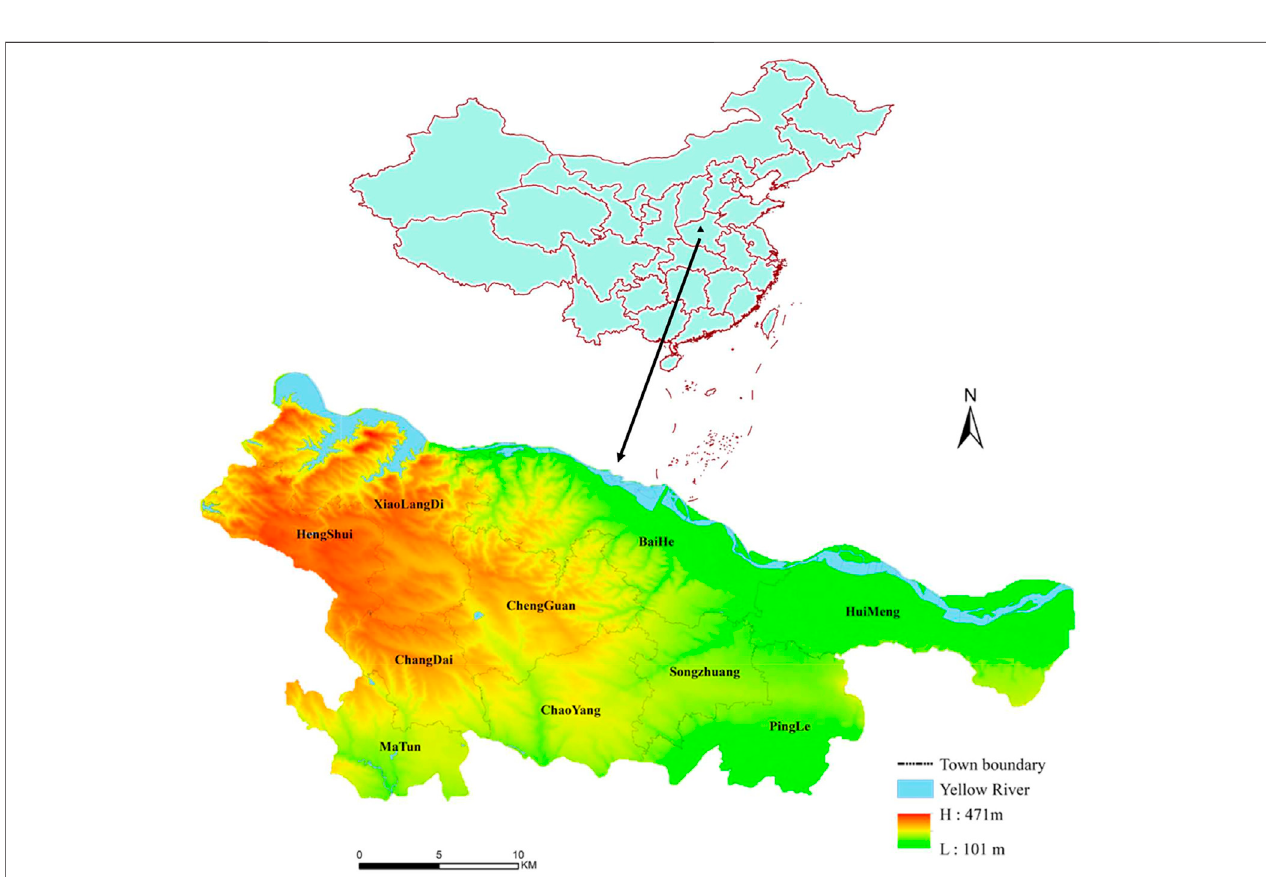
FIGURE 2 | Map of mengjin